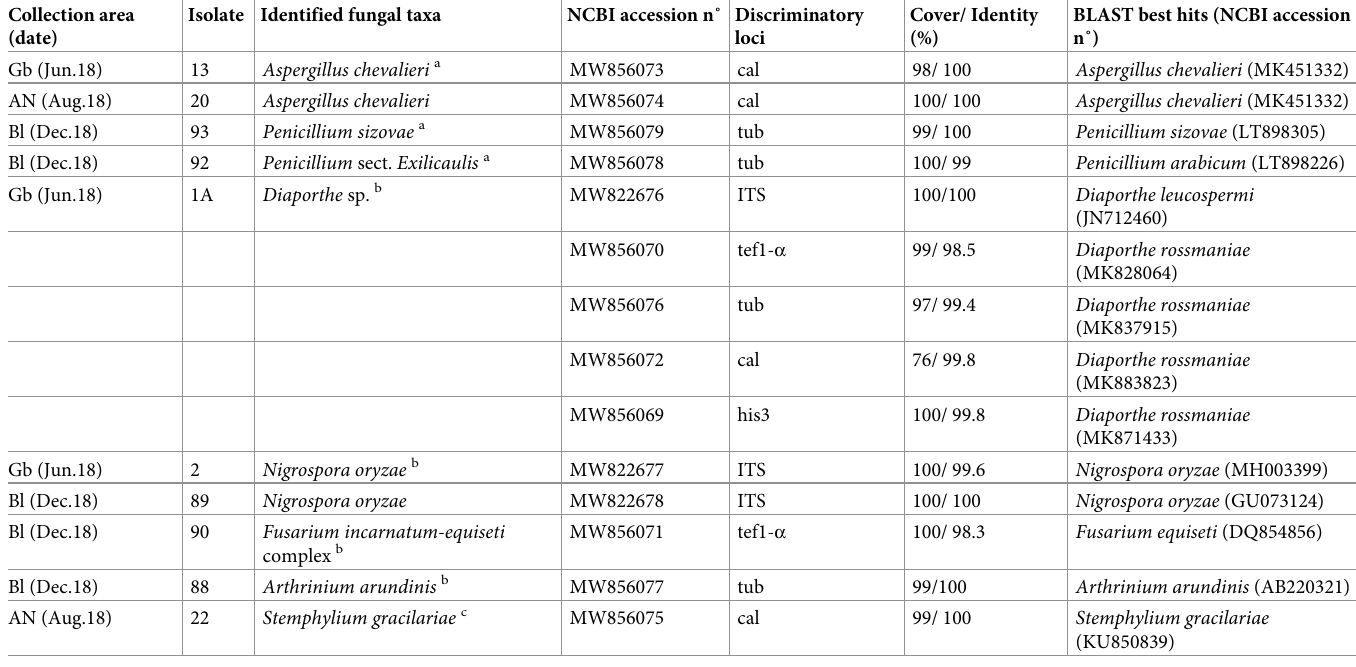
Table 1. Endophytic fungi isolated from Halopteris scoparia and molecularly identified by comparison of ITS and cal, tef1- α , tub and/or his3 sequences with those available on GenBank